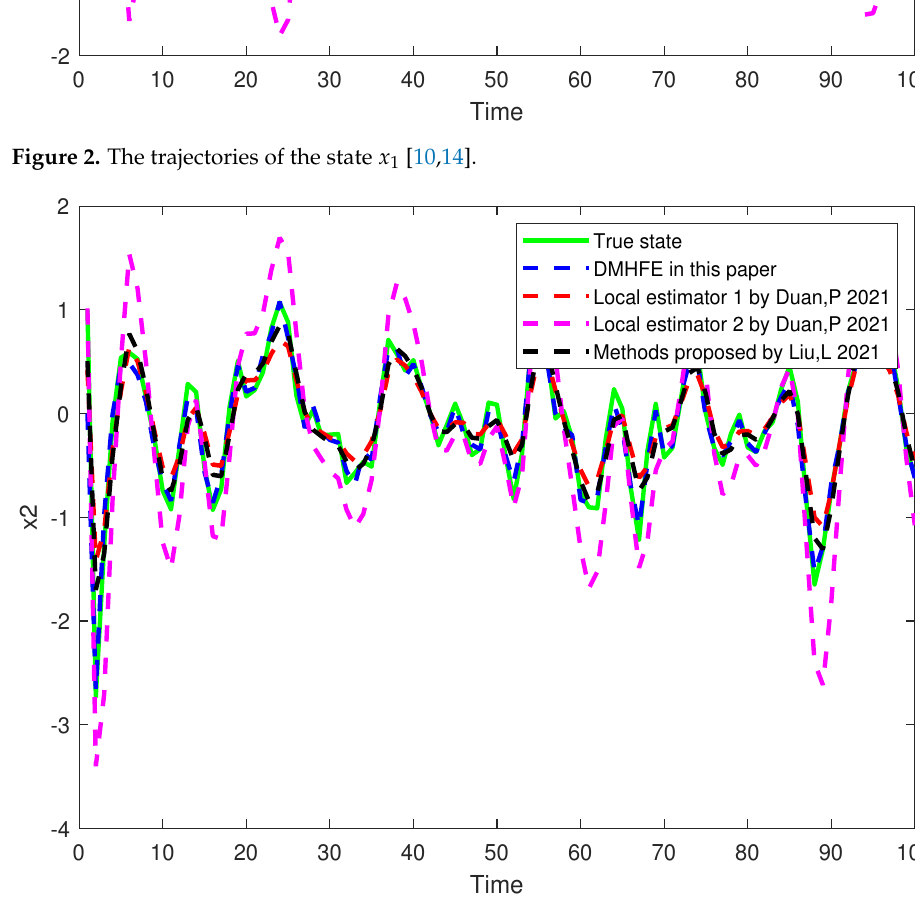
Figure 3. The trajectories of the state x 2